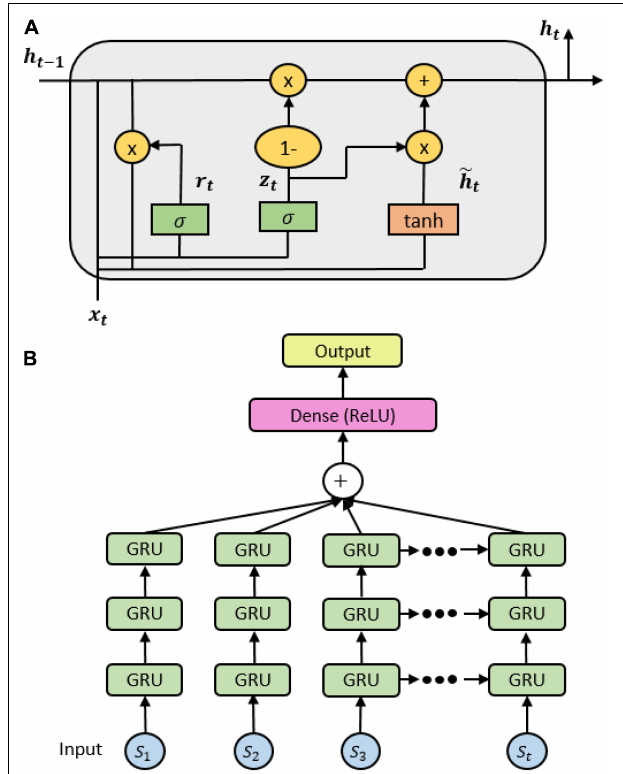
optimizer. Supplementary Table 2 presents the optimal values for these parameters.